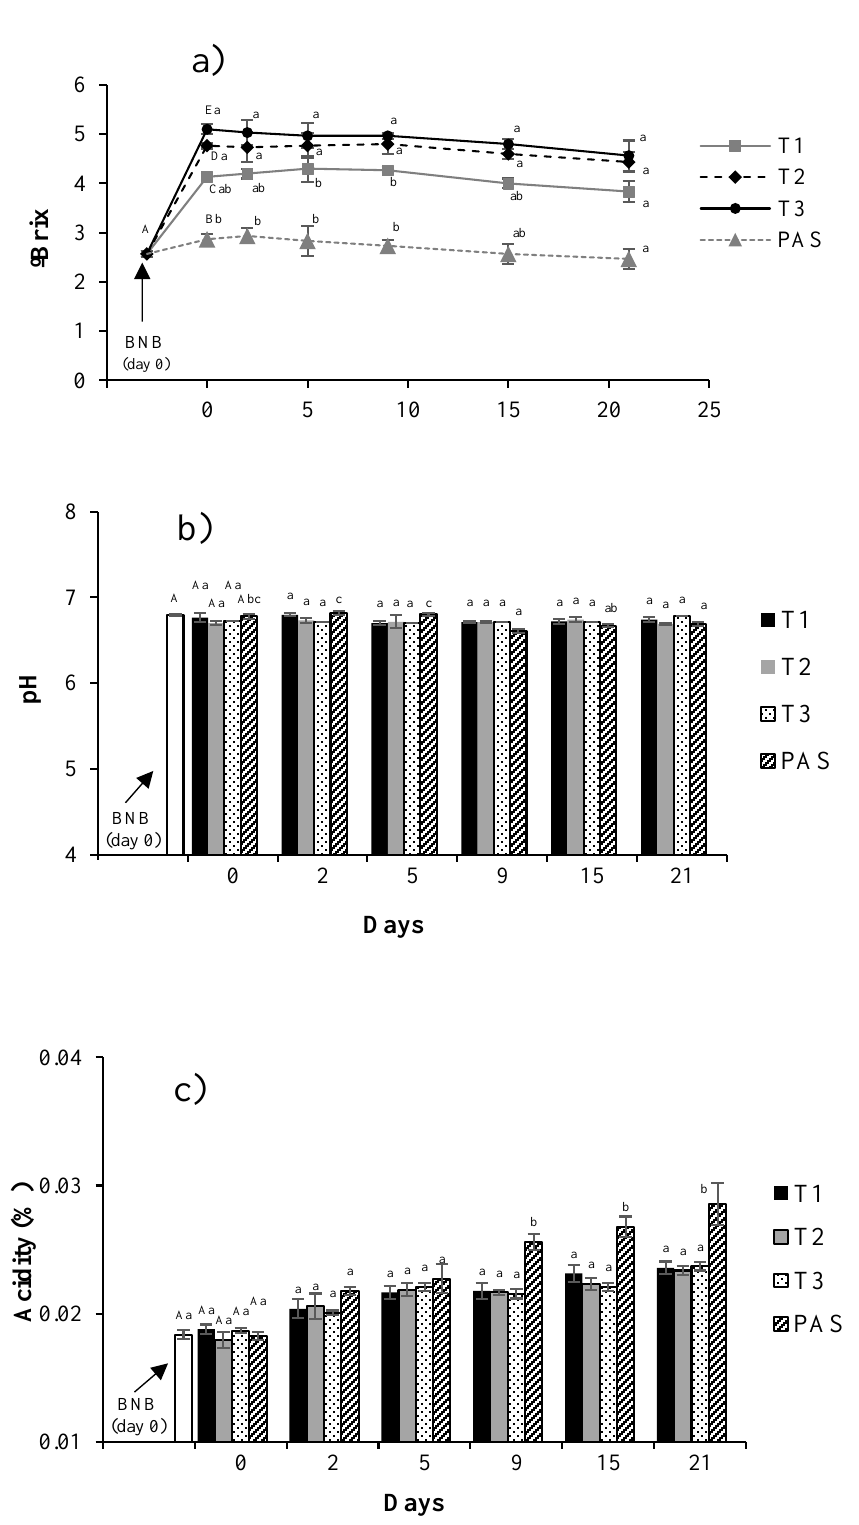
Figure 2. Physicochemical characteristics of the Brazil nut beverage (BNB) treated with high-pressure homogenization (HPH) and pasteurization (PAS) and stored and preserved at 5 ◦ C for 21 days: ( a ) Soluble solids ( ◦ Brix); ( b ) pH and ( c ) acidity (%). Data were expressed as mean ± standard deviation (n = 3). Different superscript capital letters in-dicate statistically significant differences ( p ≤ 0.05) between treatments in day 0. Different super-script lower-case letters indicate statistically significant differences ( p ≤ 0.05) between days of cold storage within the same